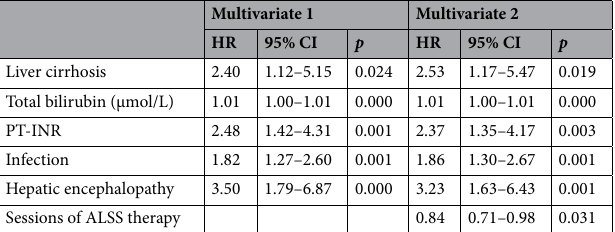
tion cohort (R 2 = 0.967, p = 0.000) matched with the validation cohort (R 2 = 0.935, p = 0.000; Suppl. Fig. S1A). Development of PALS score and PALS grade. With good applicability of the predictive model, the five individual parameters were scored. An ordinal grading (0–2) with distinct hazard ratios on logistic regression